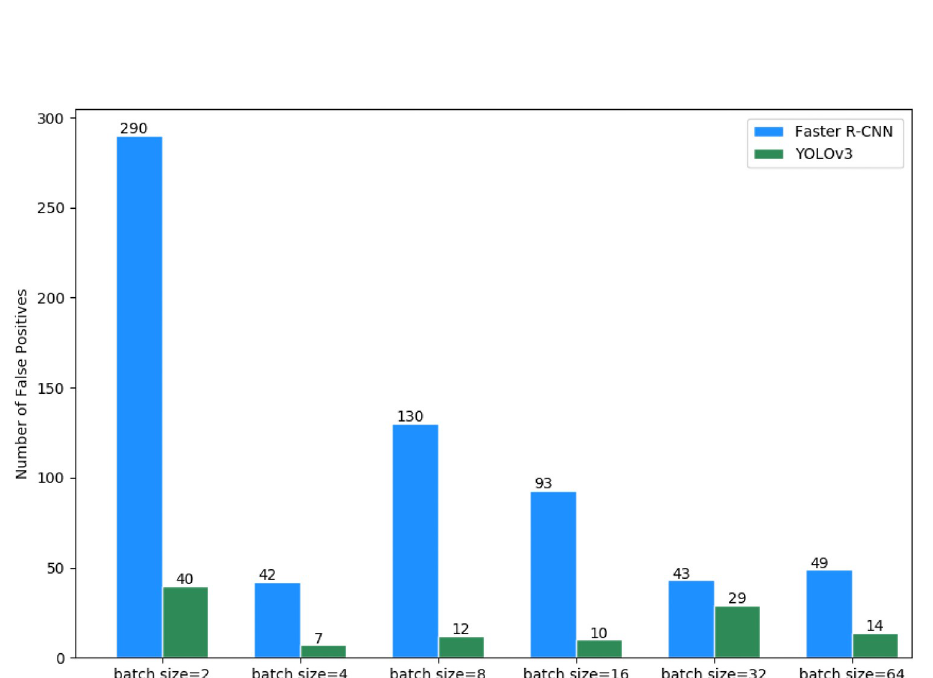
Fig 8. Comparison of the number of false positives of the Faster R-CNN and YOLOv3 architectures in different batch sizes.